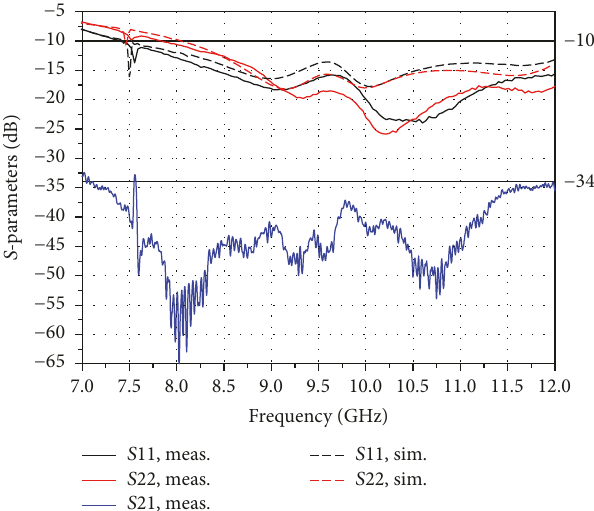
Figure 9: Simulated and measured 𝑆 -parameters of the dual-polarized Vivaldi